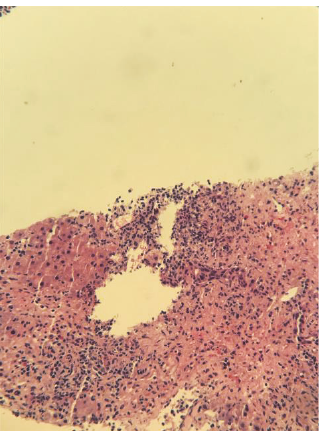
Figure 2: H&E stain of liver biopsy at low power. Liver Biopsy Pathology Report . Prominent lymphoplasmacytic infiltrate in the portal tracts with marked interface activity and multiple areas of hepatic necrosis. In some foci, plasma cells are particularly prom-